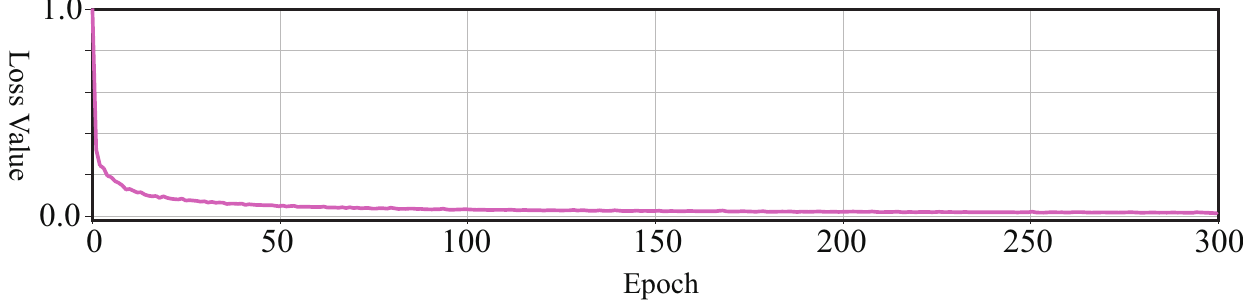
Figure 6. Loss curve in training. It illustrates that the loss was gradually minimized by training and became stable after 50 epochs. It basically got convergence after 300